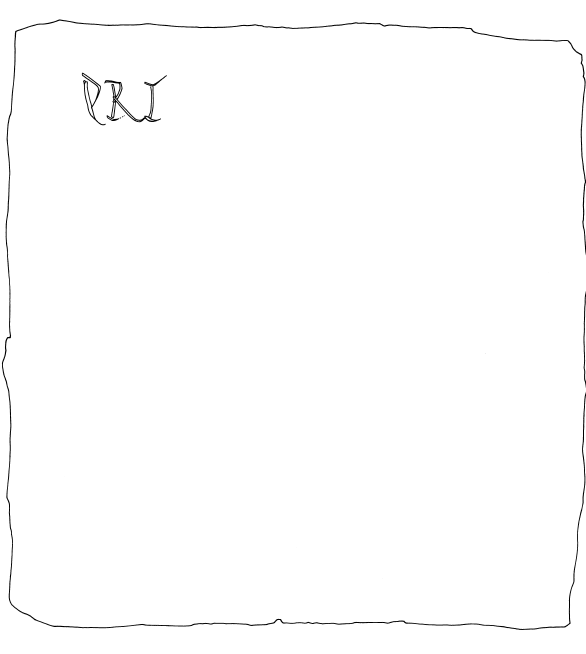
Figure 3: The front of DTM 15 (Blänsdorf 2012: CD).